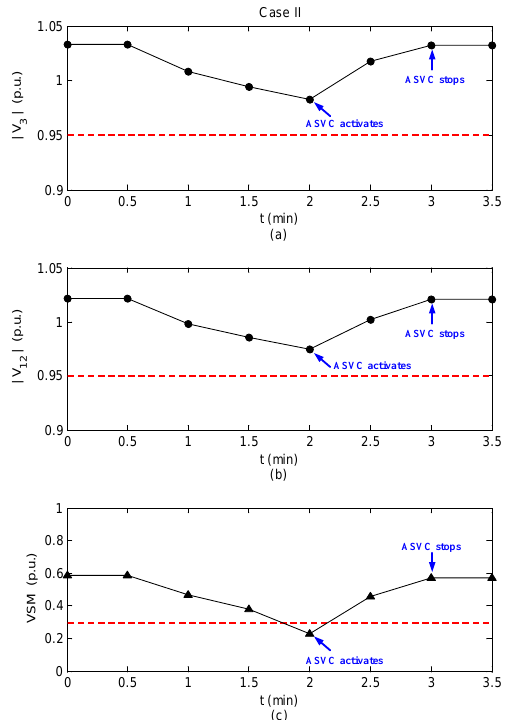
V ; ( c ) The trace of VSM. V ; ( b ) The trace of 12 3